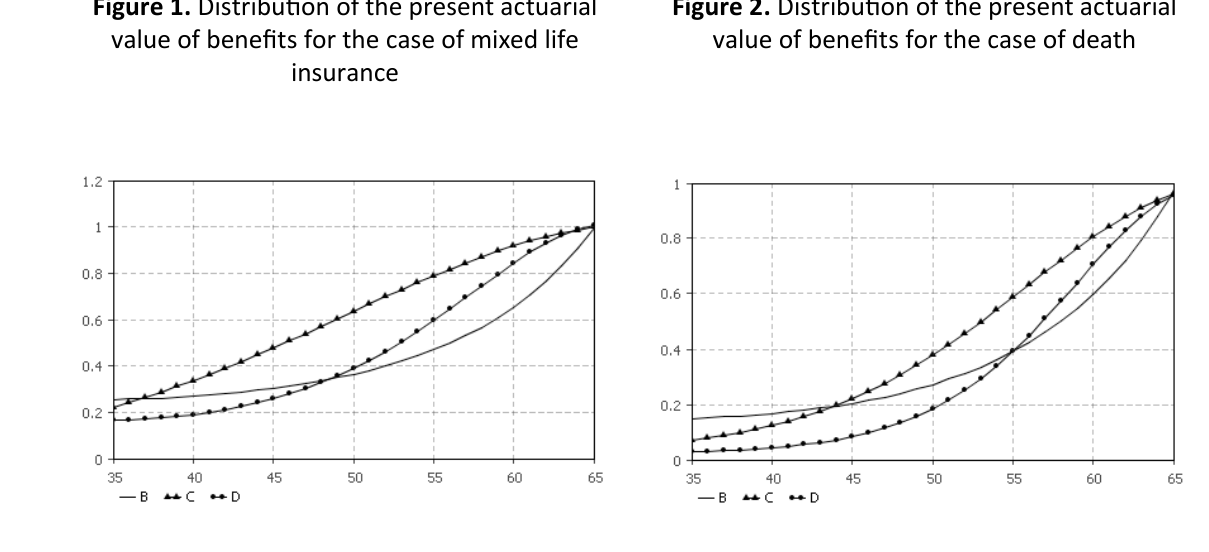
Figure 4. Distribution of the present actuarial Figure 3. Distribution of the present actuarial value of benefits for the case of death value of benefits for the case of mixed life insurance.